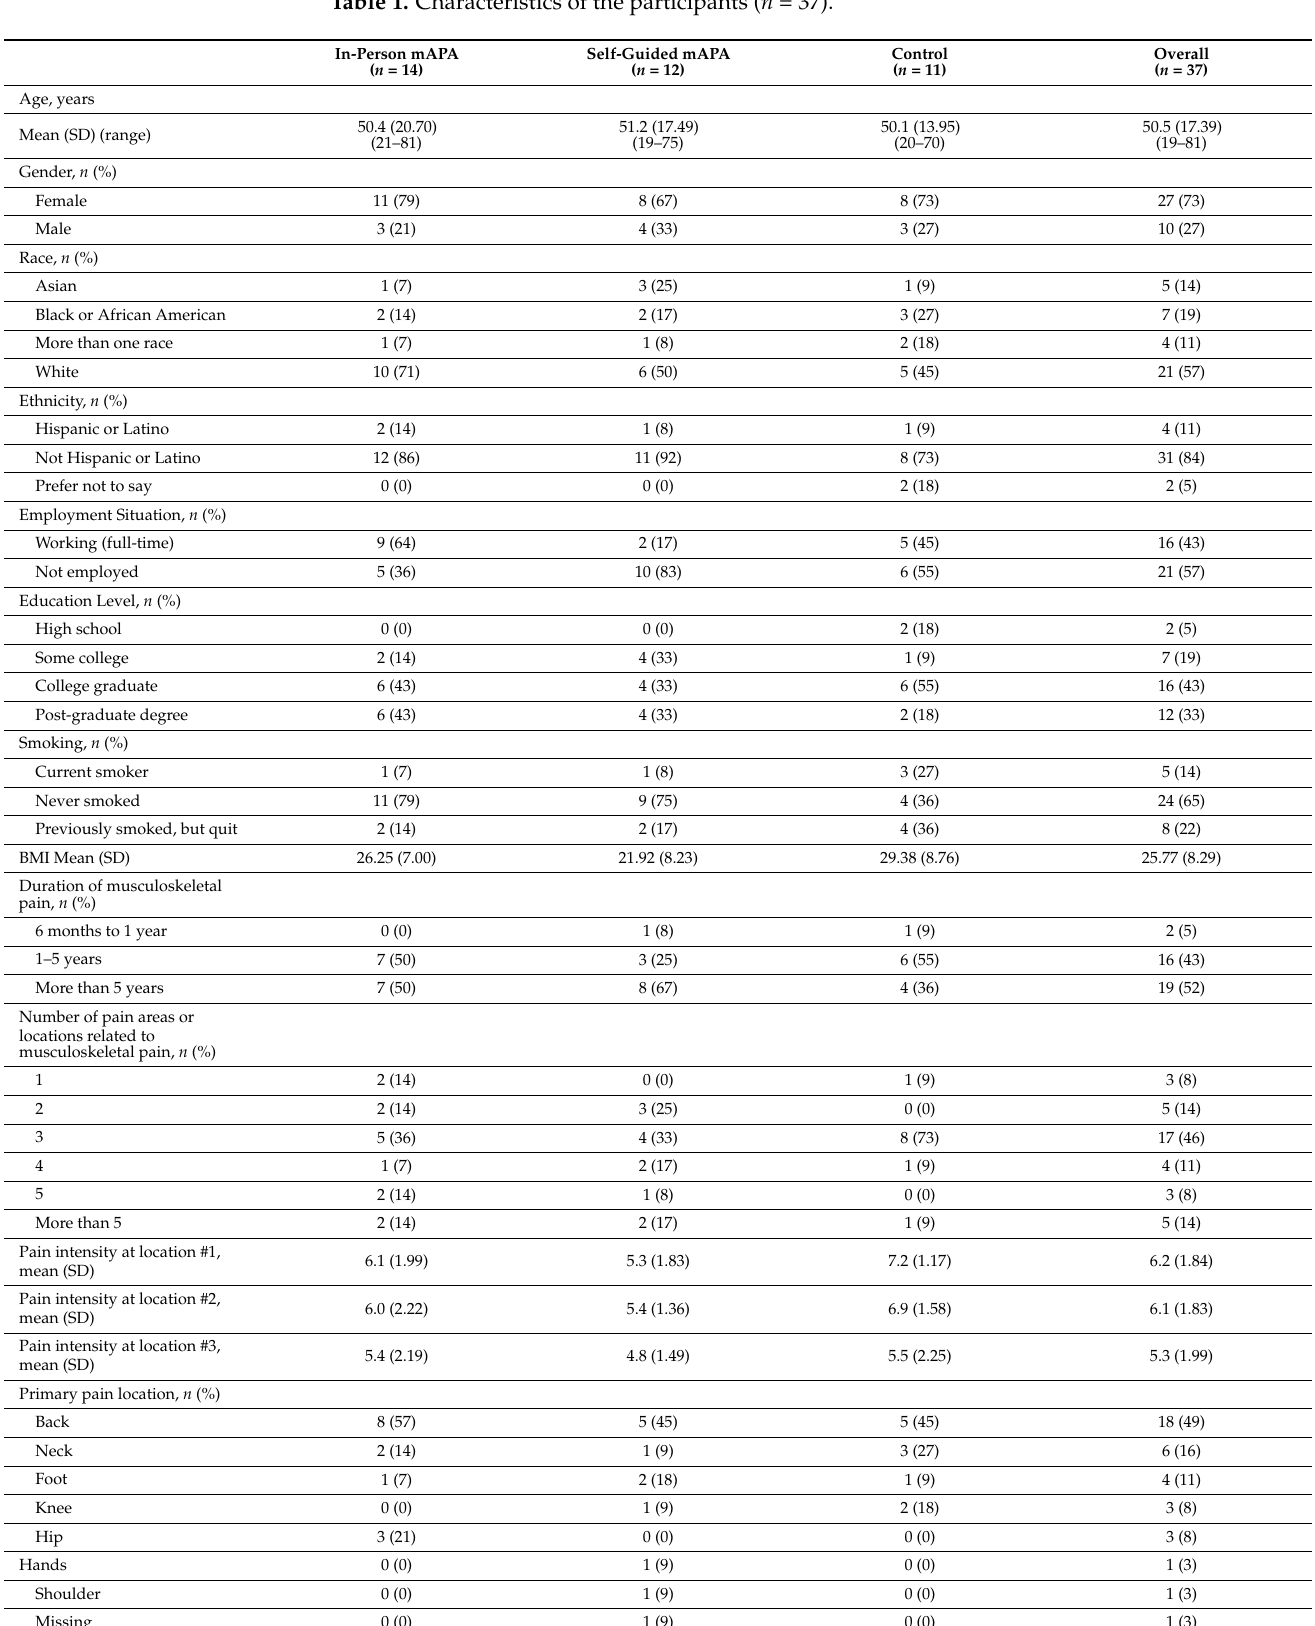
Table 1. Characteristics of the participants ( n =